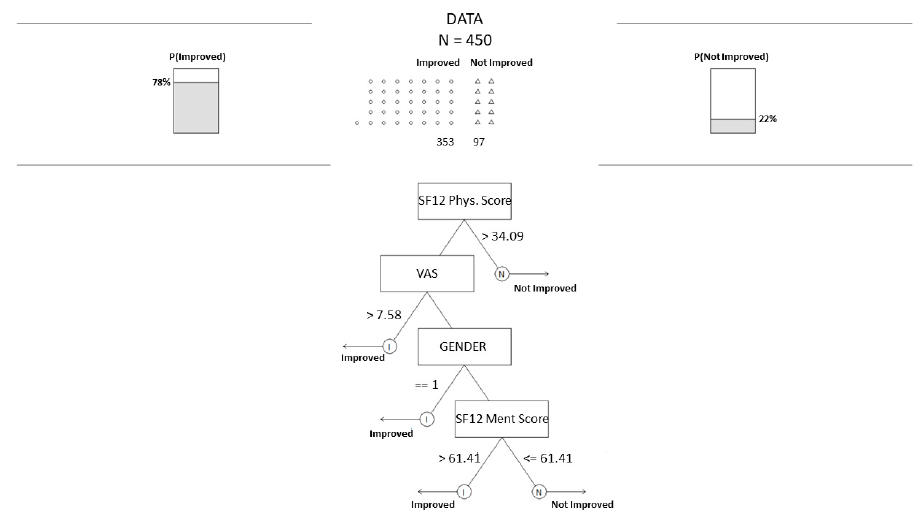
Figure 3. Fast and frugal tree, lowest complexity.